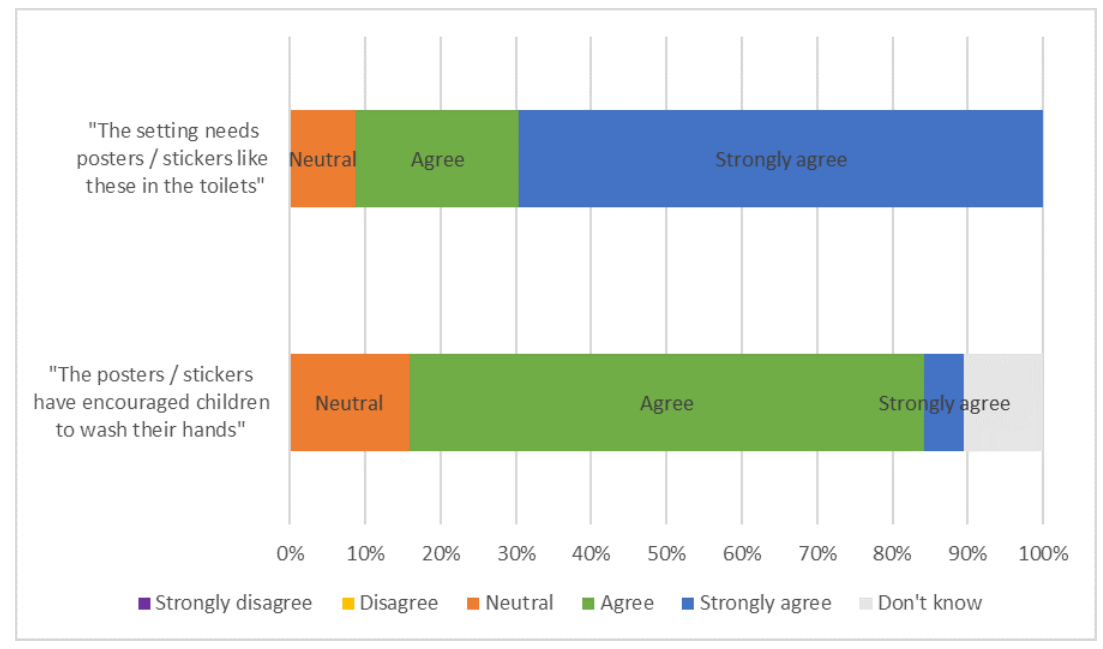
Figure 6. Stakeholder analysis results.